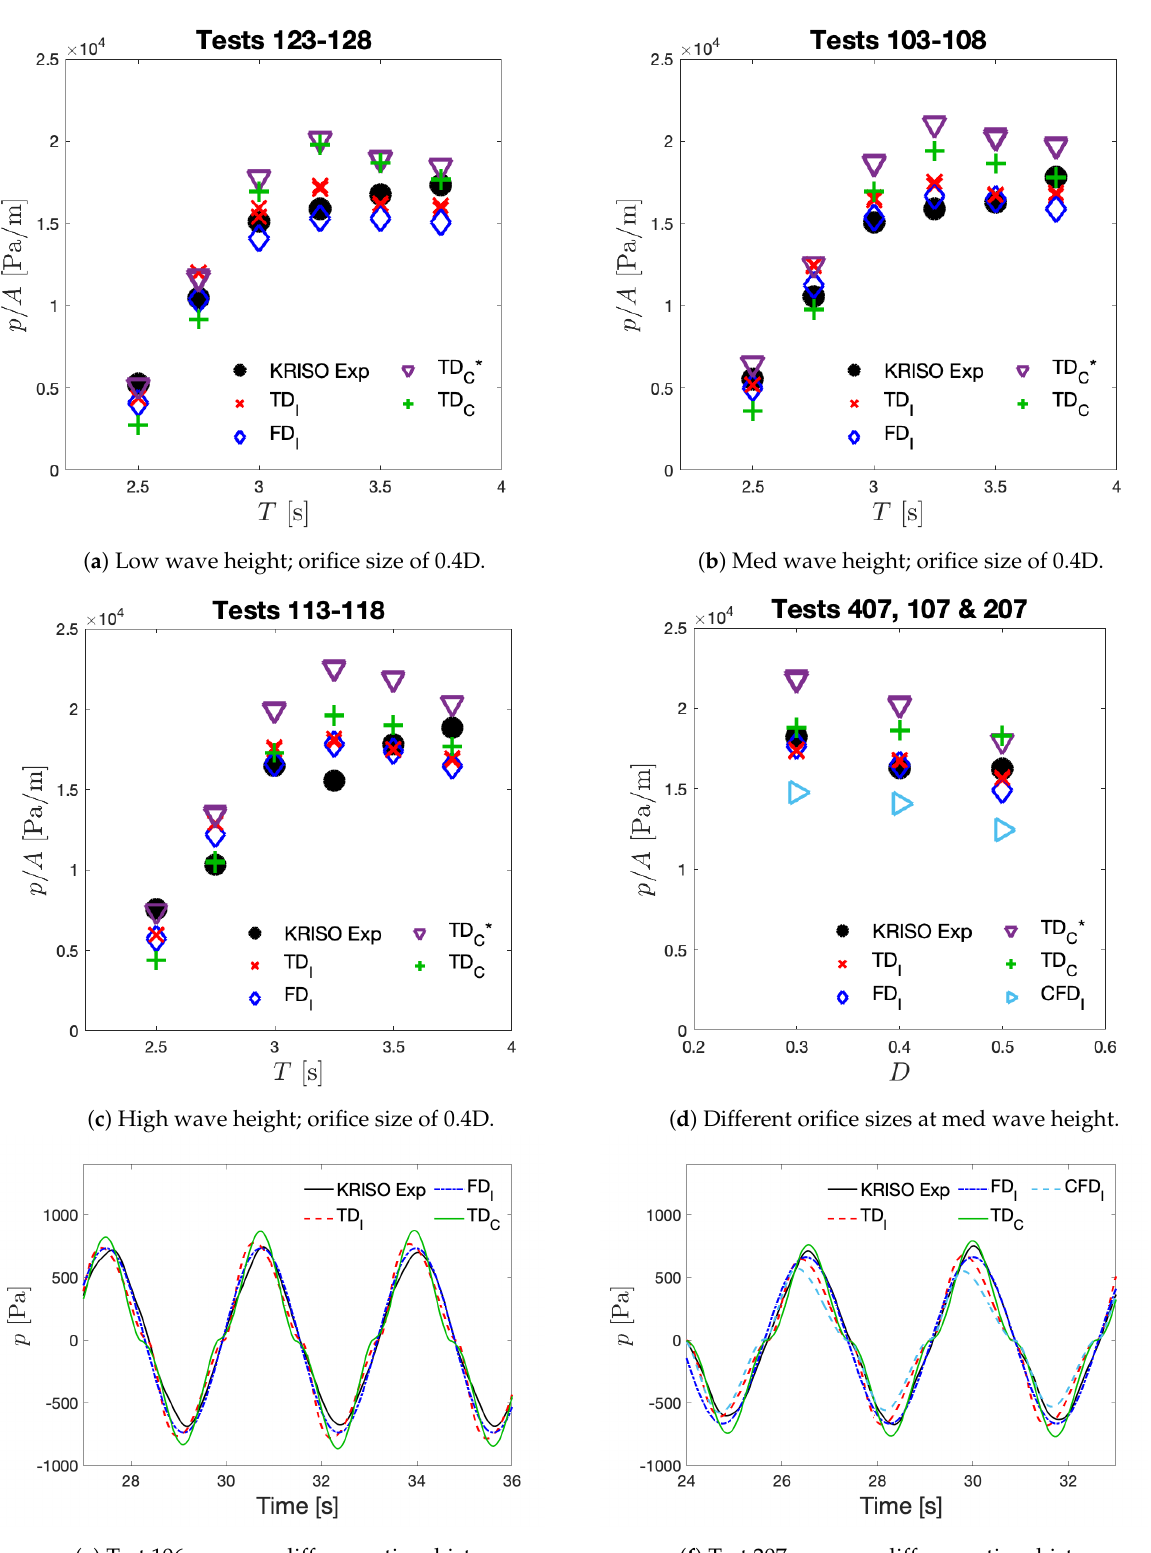
Figure 19. Comparison of the pressure difference: ( a – c ) cases with low, med and high wave heights and an orifice plate size of 0.4D; ( d ) tests with orifice plate sizes corresponding to 0.3 D , 0.4 D , and 0.5 D at med wave height; and ( e , f ) pressure difference time history for Tests 106 and 207. Superscript * indicates the 1-DOF (Degrees of freedom) model, and all the other potential flow models are 2-DOF, using both modes to approximate the internal surface motion. Subscript I and C indicate the incompressible and compressible flow models,